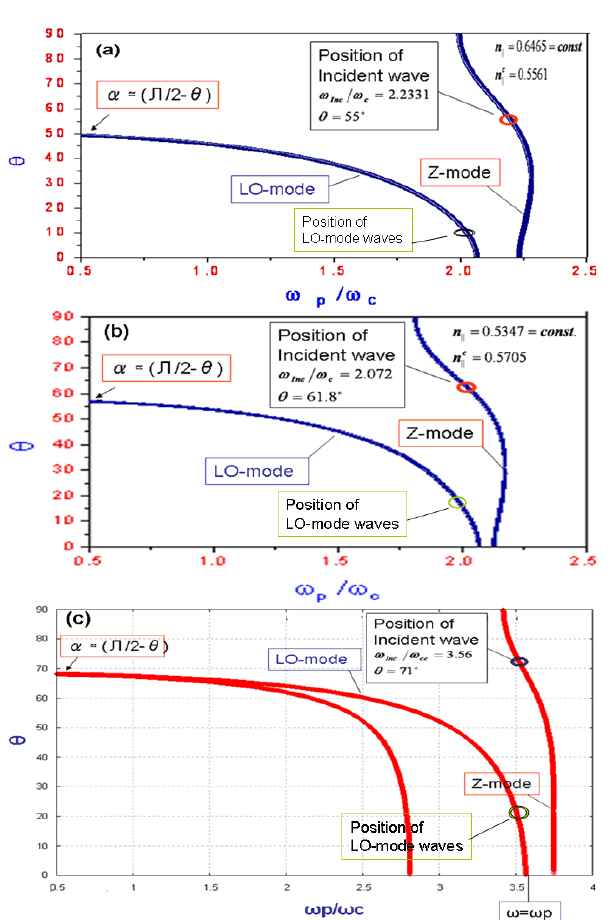
Fig. 8. Variation of wave normal angles vs. ω p (cid:14) ω ce under a con- dition that n || is constant, that slightly different with critical values, two branches of Z-mode and LO-mode waves is disconnected. Each panel corresponds to the settings used in Runs A, B and C.